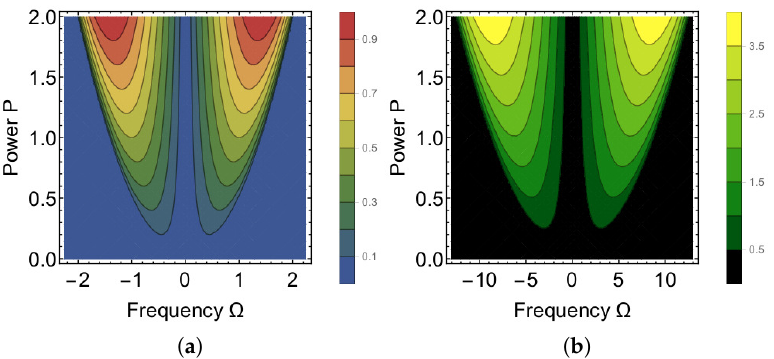
Figure 2. Contour plots showing the dependence of the MI gain on the continuous wave (CW) power, P , and perturbation frequency, Ω , for symmetric and asymmetric couplers in the anomalous-GVD regime ( σ 1 = 1). Parameters of symmetric system ( a ) are η = α = Γ = 1, κ = 2 and ρ = χ = 0. For the asymmetric system ( b ), η = α = 0.1, Γ = 2, κ = 1, ρ = 0.1, and the phase-velocity mismatch is defined in terms of P , in order to produce the largest gain: χ = − 4.95 + 0.985 P . Note the difference in horizontal scales between (a) and (b).